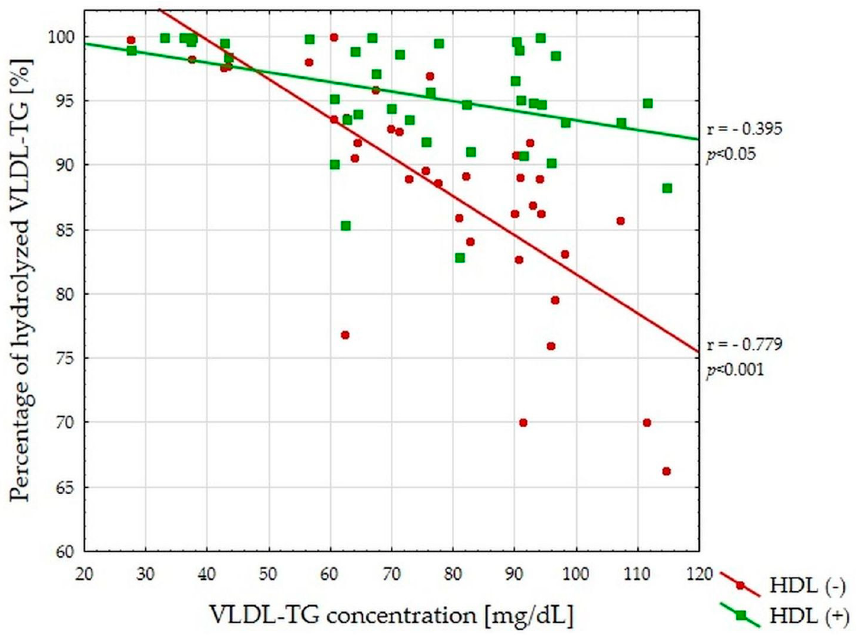
Figure 1. The relationship between very-low-density lipoprotein triglyceride (VLDL-TG) concentra- tion (mg/dL) and percentage of VLDL-TG hydrolyzed during lipoprotein lipase (LPL)-mediated lipolysis for all study subjects ( n = 40). HDL: high-density lipoprotein.